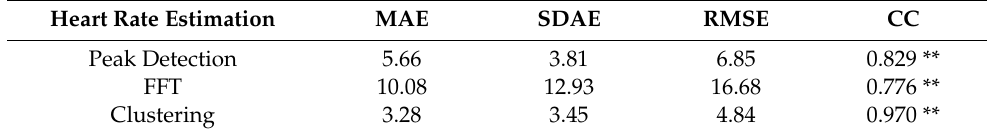
Table 3. Estimation of heart rates from the dataset including the motion artifacts by facial expressions. Heart Rate Estimation